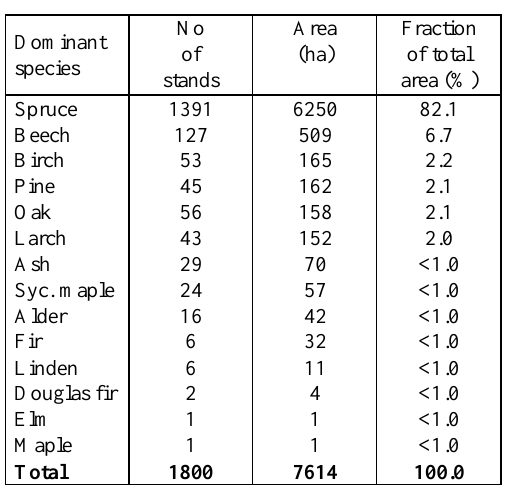
Table 1 . Forest stands structured by dominant